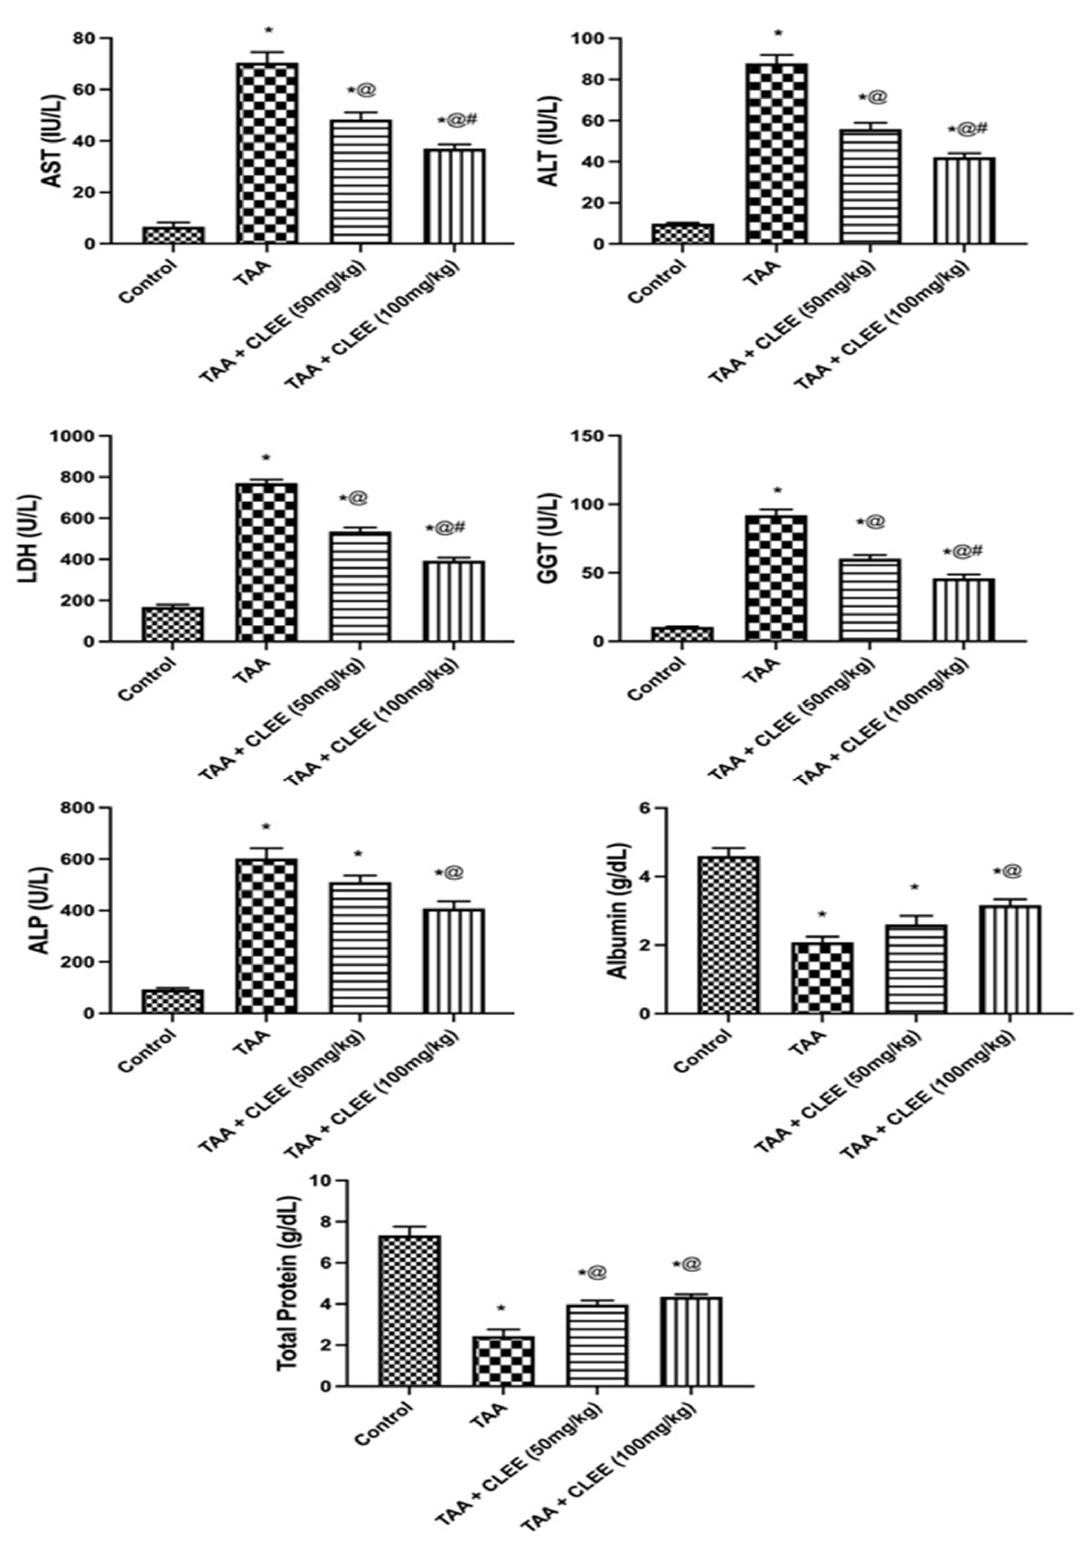
Figure 3. Effect of CLEE on liver function parameters of rats intoxicated by TAA. Each value represents the mean of six animals ± SE. Statistical analysis was performed using one-way ANOVA followed by the Tukey-Kramer multiple comparisons test. (* vs. control group, @ vs. TAA group and # vs. TAA + 50 mg /kg b.w. CLEE group) at p < 0.05.